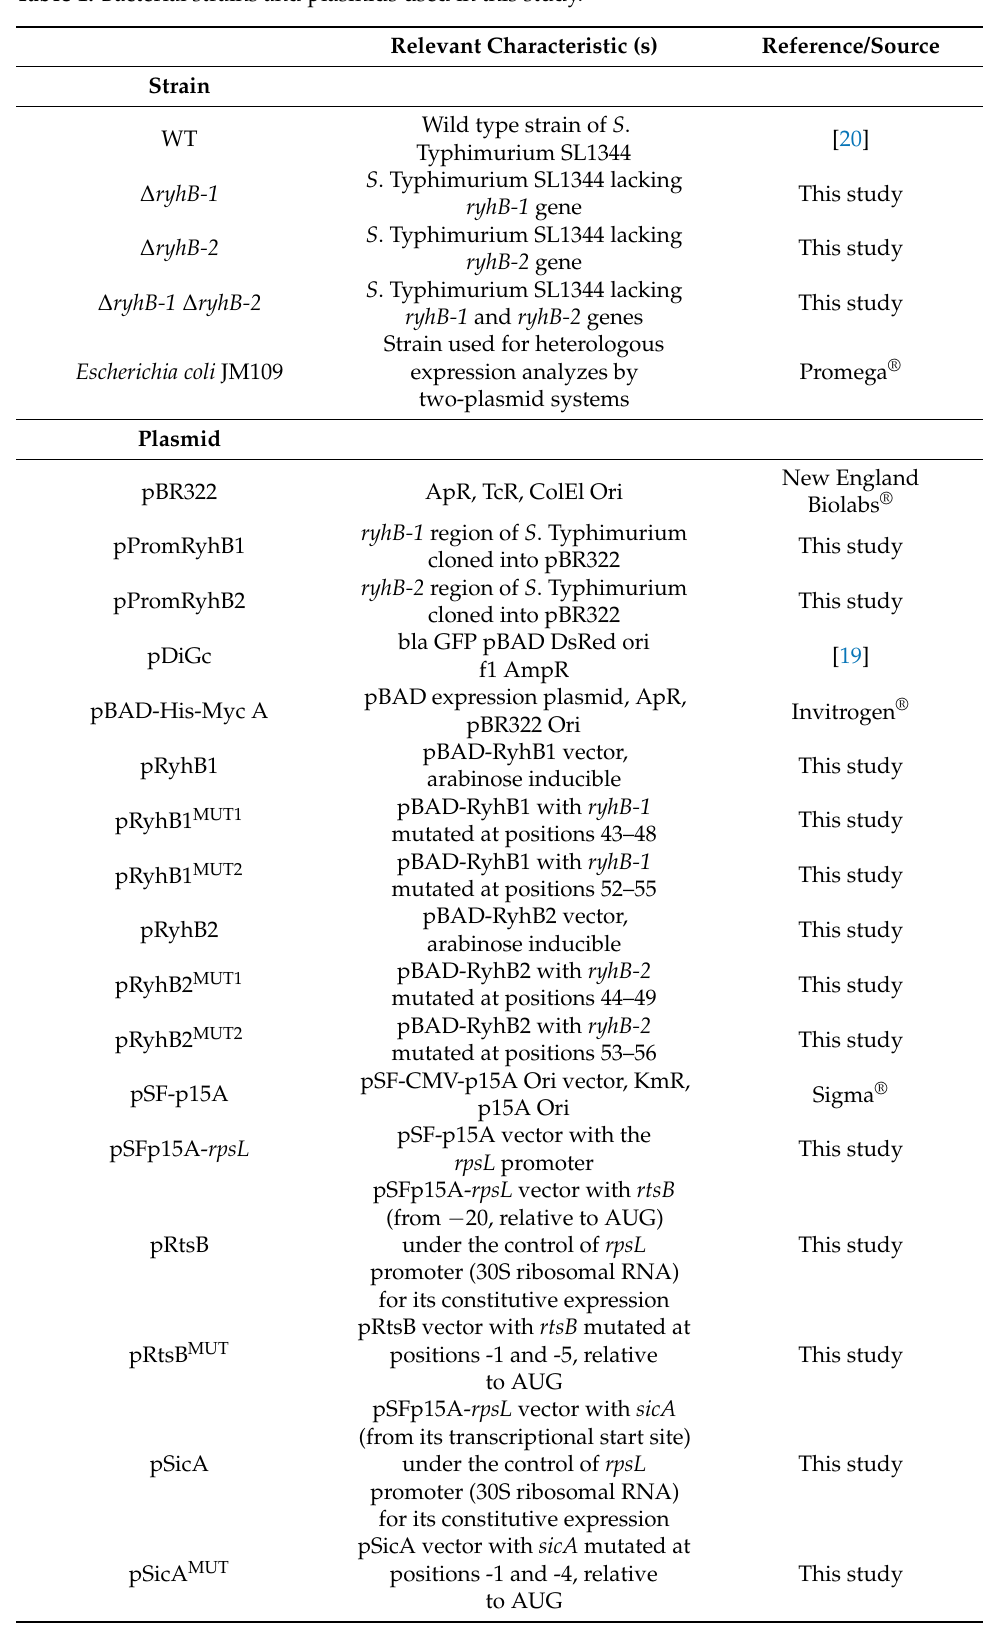
Table 1. Bacterial strains and plasmids used in this